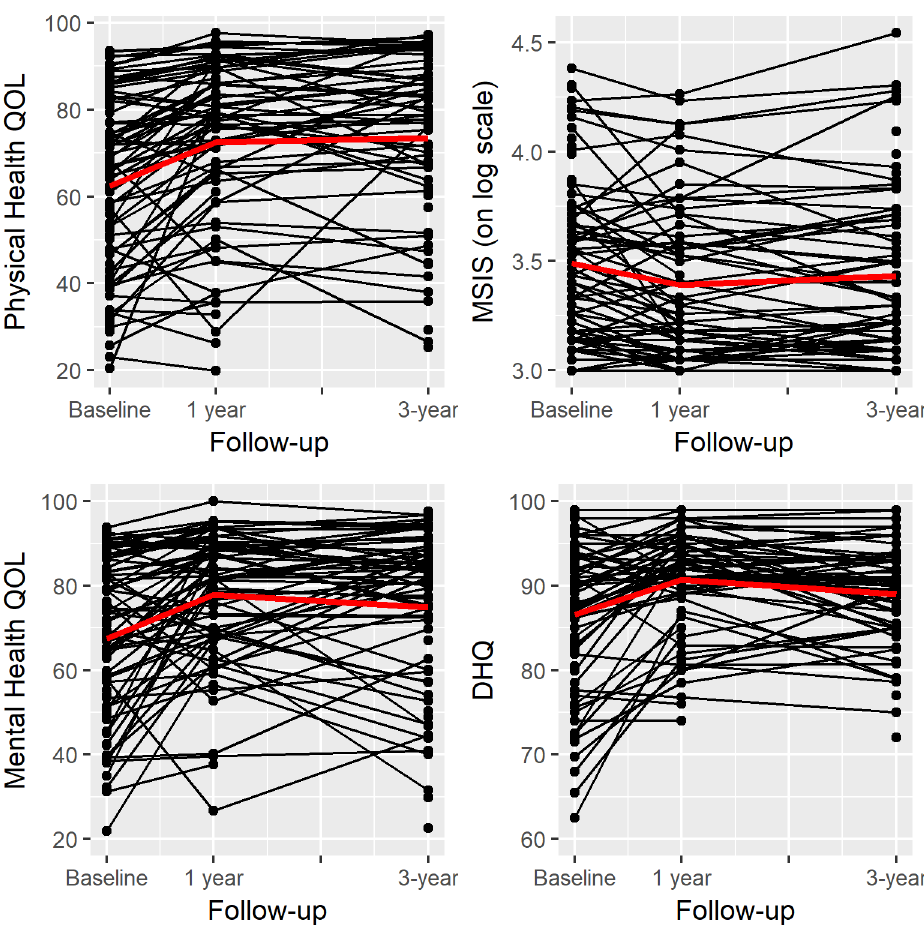
Fig 1. Changes observed over time in physical and mental health quality of life, disability, and diet. Quality of life was measured with the MSQOL-54, disability was measured by MSIS on log scale, and diet was measured by the DHQ.